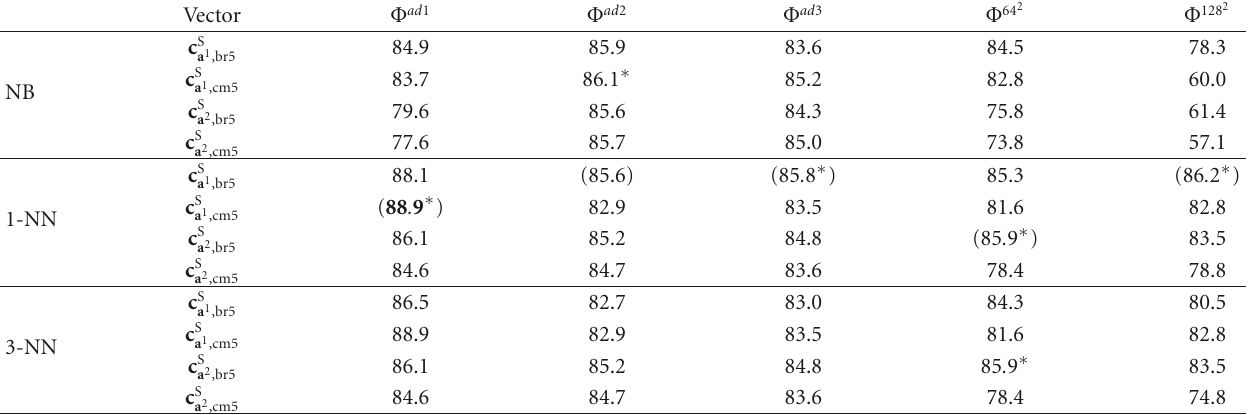
Table 7: Rate C P of correctly classified patterns for five image sets with Stripe’s features. The best rates C P for each image set are shown by an ∗ . The best rates C P for each image set and for a 1-NN classifier are depicted in